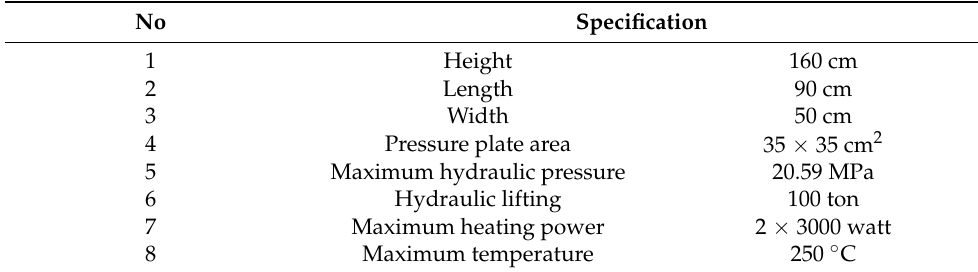
Table 3. Specification of the hot press used.